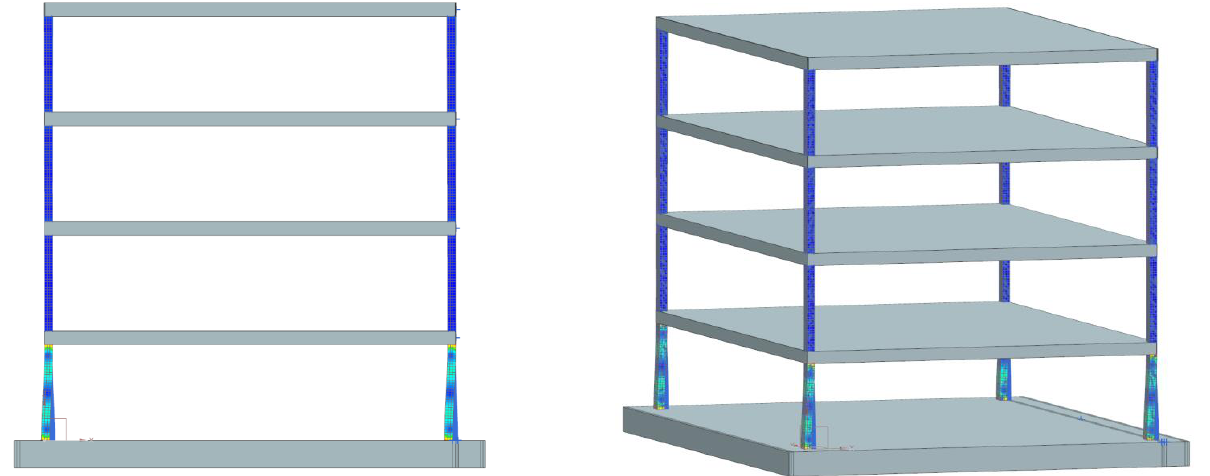
Figure 15. Maximum building deflection recorded during the simulation of a system with the use of vibration-reducing force.